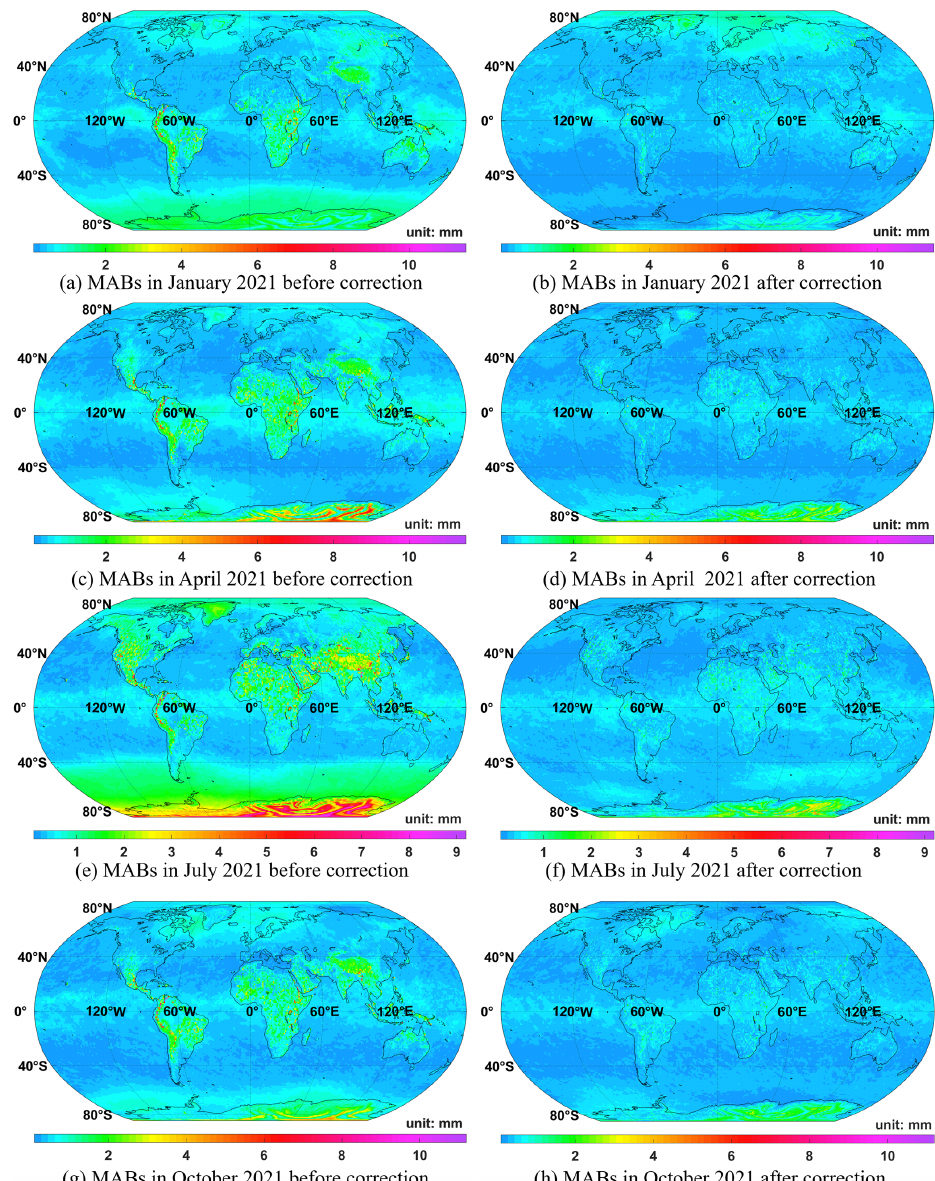
Figure 11. Global MABs before (left ones) and after (right ones) correction by the grid model over January (a–b) , April (c–d) , July (e–f) , and October (g–h) in 2021. Please note that the color bar of each month is